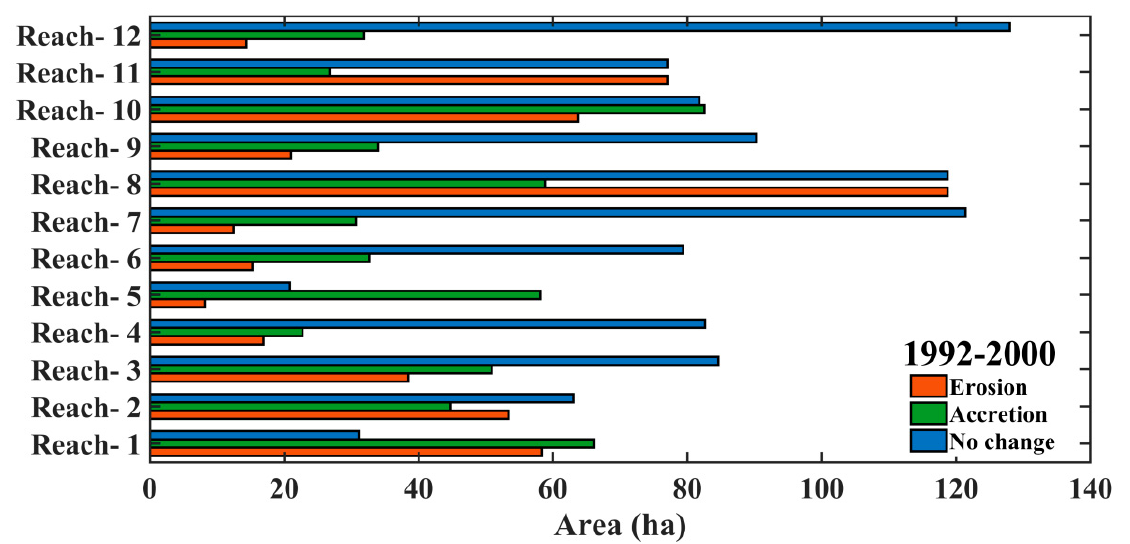
Figure 8. Erosion, accretion, and unchanged area at various reaches (1–12) between 1992 and 2002.